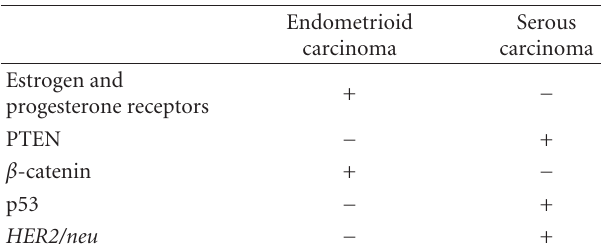
Table 3: Typical immunoprofile of type I endometrioid carcinoma and type II serous